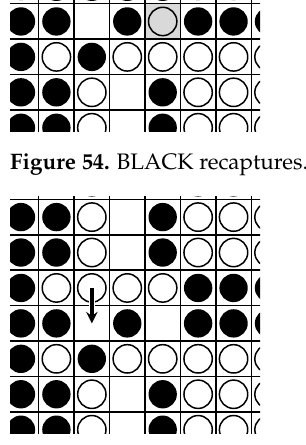
Figure 55. WHITE’s second turn.